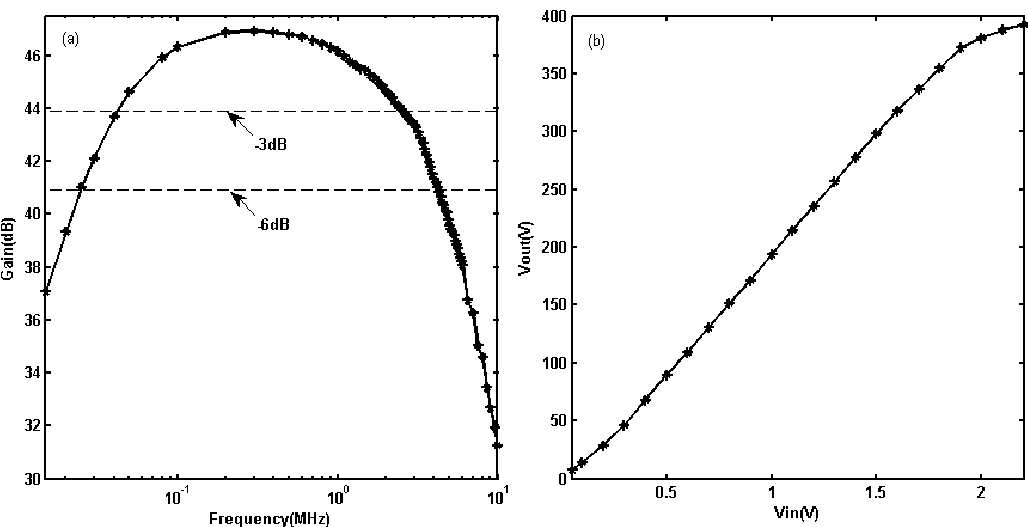
Figure 9. Evaluation of the proposed linear PA with feedback: ( a ) gain distribution from 15 kHz to 10 MHz; ( b ) Output voltages with increased input voltages at 300 kHz.